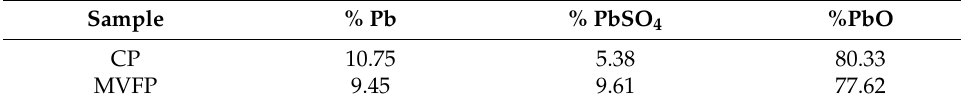
Table 3. Chemical analysis of the negative pastes before curing.